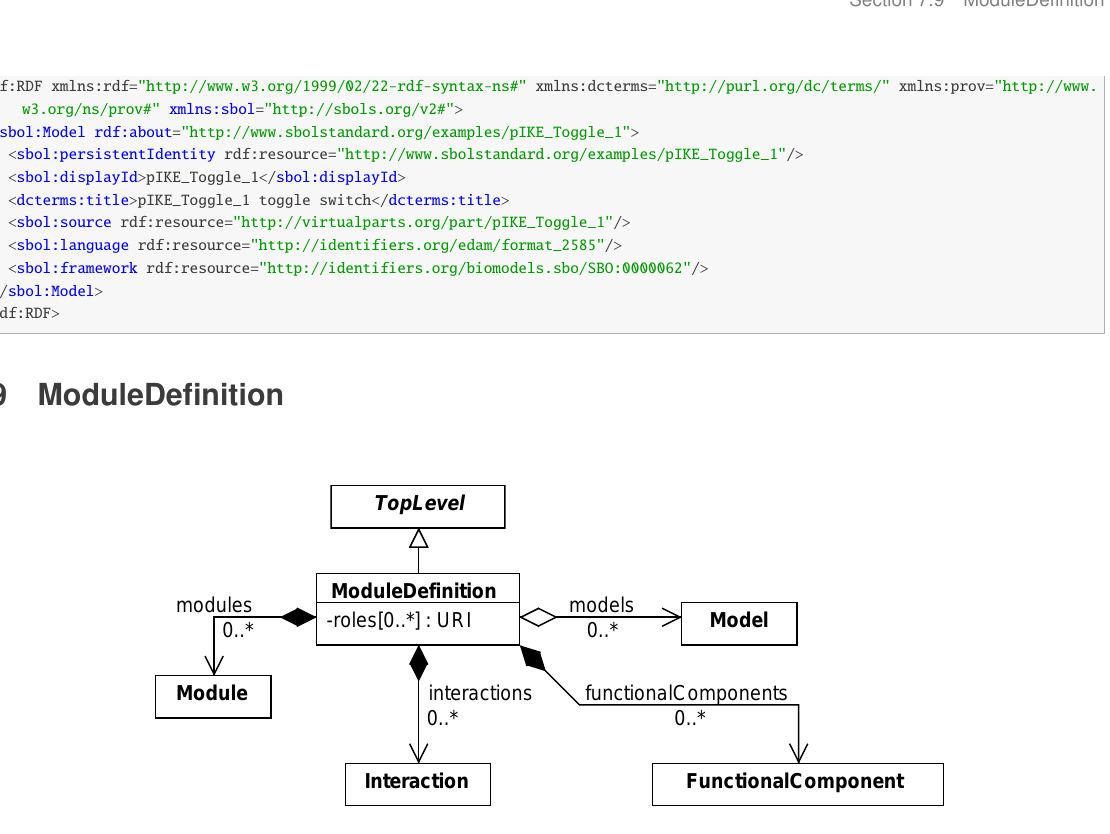
Figure 15: Diagram of the ModuleDefinition class and its associated